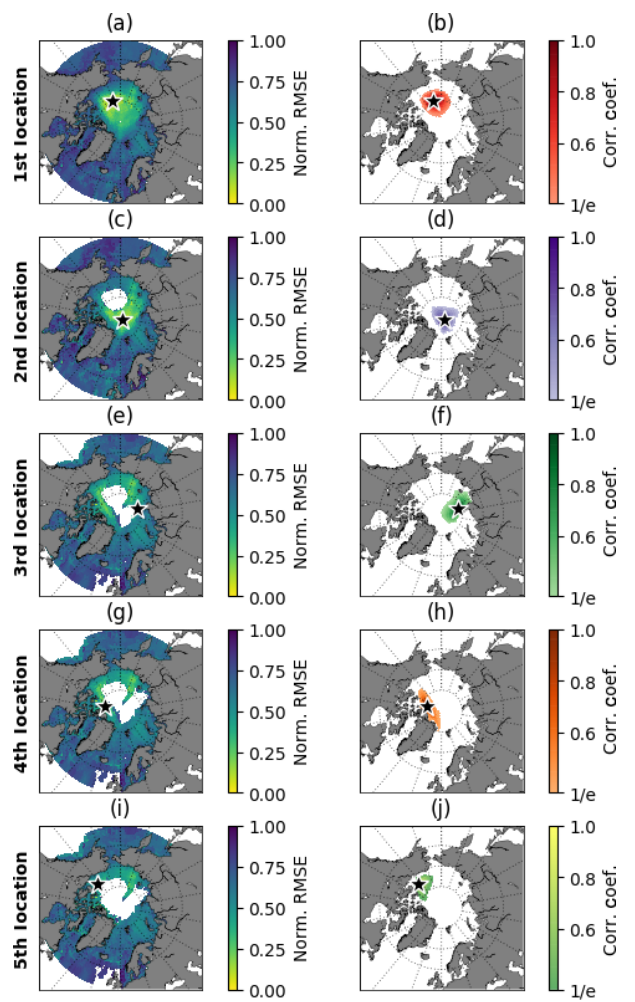
Figure 7. (a) Ensemble mean–normalized score map (ScNorm) for the first best sampling location. (b) The region of influence is de- fined for the first best location. The panels (c, d) , (e, f) , (g, h) , and (i, j) represent the same as (a, b) but for the second, third, fourth, and fifth best sampling locations, respectively.